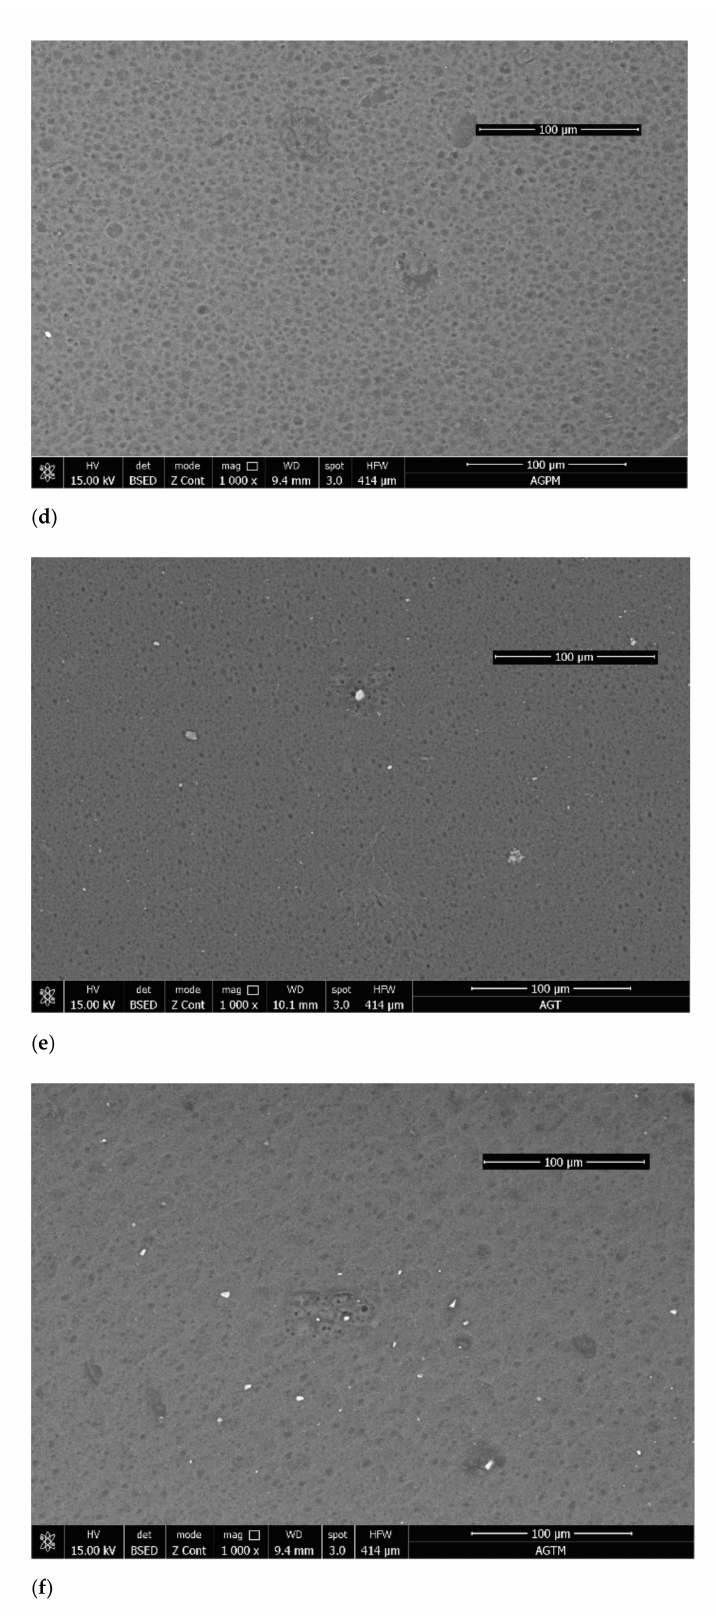
Figure 11. SEM image of the ( a ) AG, ( b ) A-MTX, ( c ) AGP, ( d ) AGP-MTX, ( e ) AGT and ( f ) AGT-MTX